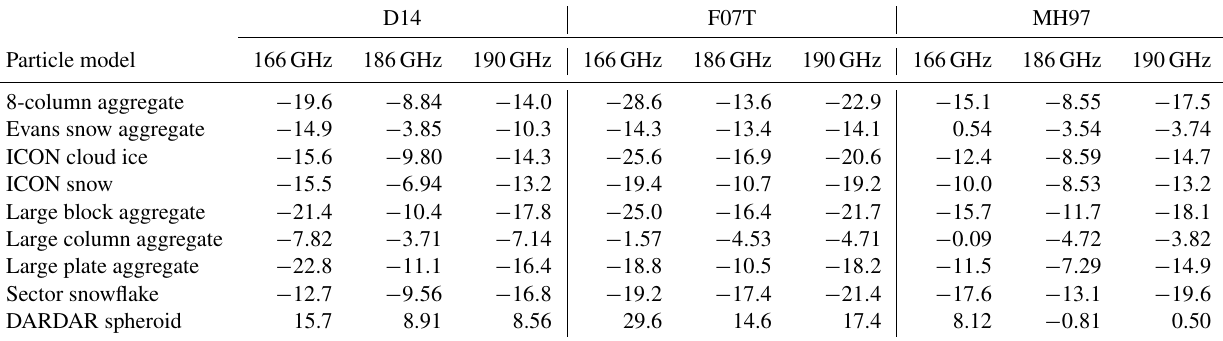
Table 2. Differences between the means of simulated and GMI-observed TBs (see Eq. 7) in units of Kelvin. Only TBs below 240K are considered, essentially filtering out clear-sky